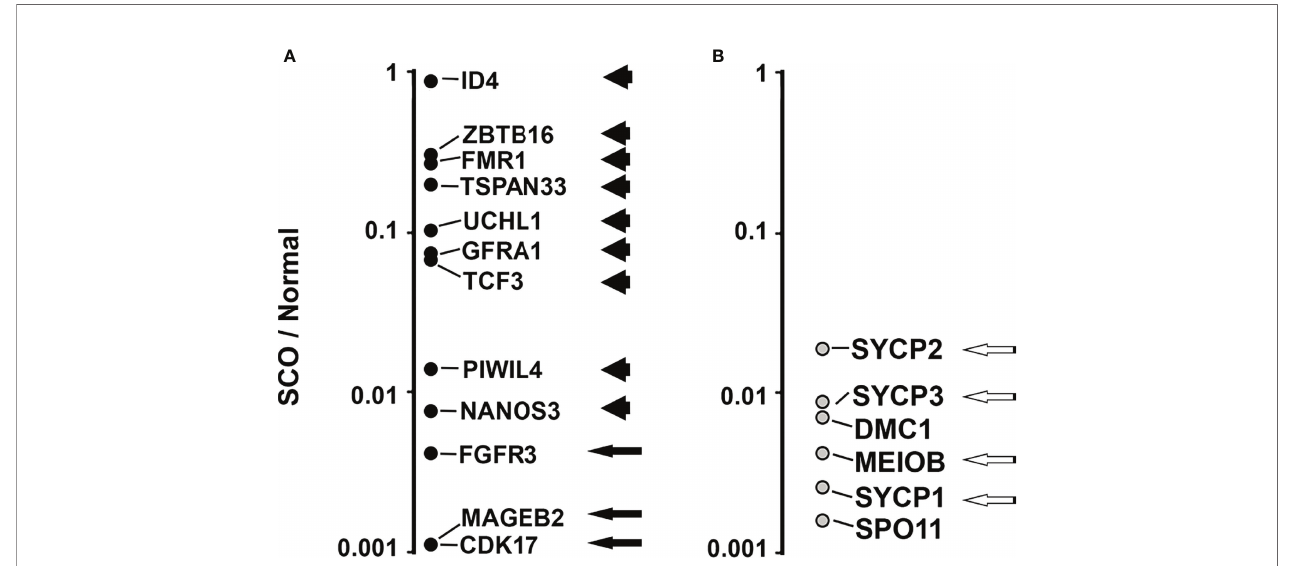
FIGURE 5 | Comparing the abundance of 13 transcripts that are consensus markers of human SSCs (A) and 6 transcripts that are consensus markers of human pachytene spermatocytes (B) in the transcriptomes of 7 human SCO testes and 4 normal testes. All 19 consensus markers were identi fi ed in the transcriptomes of the 4 normal testes. Nine of the 13 SSC markers were identi fi ed in the transcriptomes of all 7 SCO testes (Panel A , arrowheads). Three SSC markers were present in the transcriptomes of 5 SCO testes (Panel A , black arrows). An additional SSC marker, NANOS2, was not present in the transcriptome of any SCO testes. (NANOS2 data are not shown in panel (A) . Four markers of pachytene spermatocytes, were present in all 7 SCO transcriptomes (Panel B , white on black arrows). DMC1 and SPO11 were present in 5 and 1 of the transcriptomes of SCO testes, respectively. To compare differences between SCO and normal testes in the abundance of each marker, we fi rst normalized data by dividing the abundance of each marker in each transcriptome by the abundance of b actin mRNA in the same transcriptome. We then calculated the average normalized abundance of each marker in the transcriptomes of SCO testes and in the transcriptomes of normal testes. To illustrate the normalized abundance of 18 of the 19 markers in SCO testes (NANOS2 not shown), data for each SSC consensus marker (A) and each pachytene spermatocyte consensus marker (B) are presented as a ratio (SCO/Normal). Except for ID4, the abundance of each SSC marker is substantially lower in SCO testes than in normal testes. The median ratio (SCO/Normal) for the abundance of the 13 SSC markers was 0.07. The median ratio for abundance of the 6 pachytene spermatocyte markers was 0.004. Thus, some SCO testes contain SSCs, but few support the production of pachytene spermatocytes. The transcriptomes of normal and SCO human testes are described in Paduch et al. (42), and RNAseq data deposited in the NCBI dbGAP database, accession number: